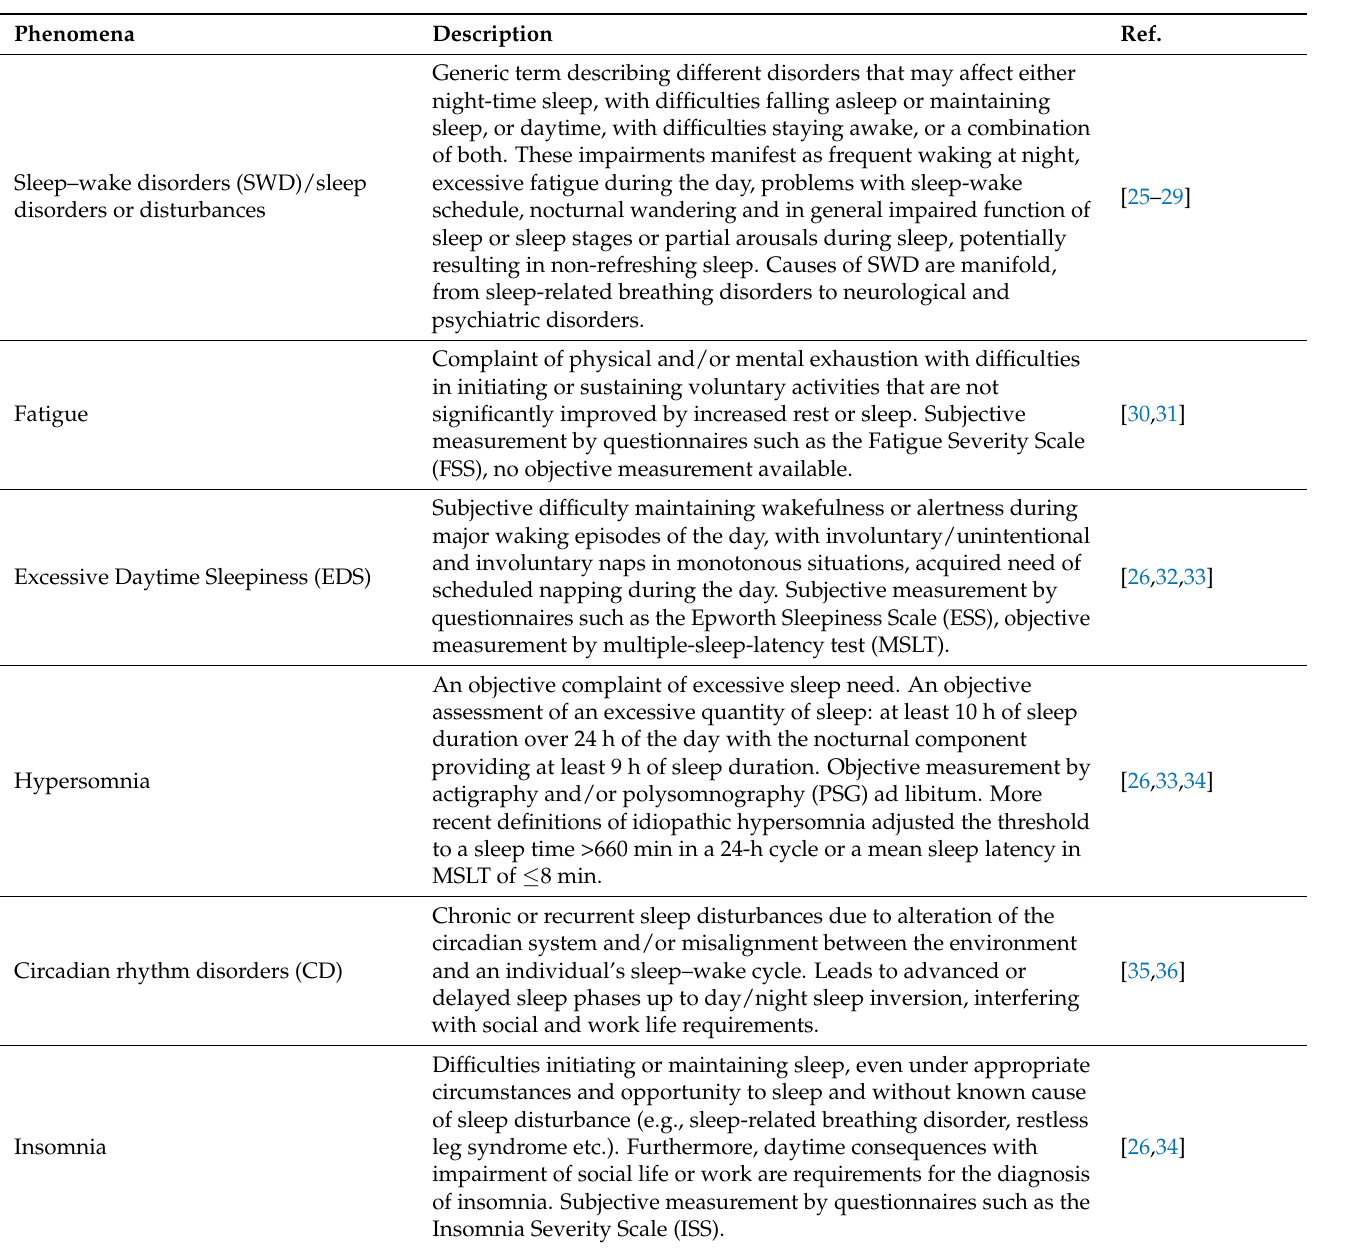
Table 1. Definitions of sleep-wake and circadian